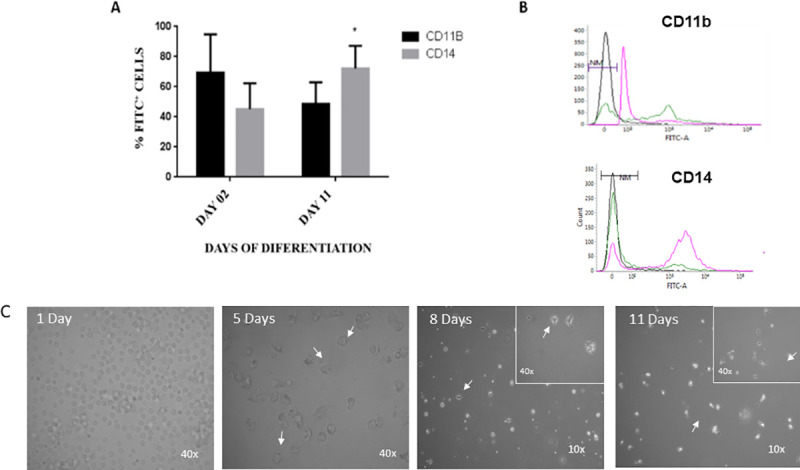
In vitro differentiation of bovine monocytes (CD11bhiCD14low) into macrophages (CD11b lowCD14hi) characterized by flow cytometry and light microscopy.(A) Percentage of mononuclear cells expressing CD11b (black boxes) and CD14 (gray boxes) receptors on cellular membrane on days 2 and 11 after in vitro macrophage differentiation (n = 6; average ± SD; *P = 0.015). (B) Representative overlapped histograms displaying fluorescence intensity on FITC channel unstained cells (NM; black line) and individual acquired CD11b FITC and CD14 FITC stained cells on day 2 (green line) and day11 (pink line) after monocyte isolation and differentiation into macrophages. (C) Typical photos of bovine monocyte differentiation into macrophages taken by optical microscopy showing its original magnification (x10 or x40) and the number of days in cell culture (1, 5, 8 and 11 days). White arrows indicate cells with adherence to the flasks at day 5; cells spreading and acquiring primary shape of macrophage at day 8; and final differentiation into macrophage at day 11 showing elongation and spreading patterns.